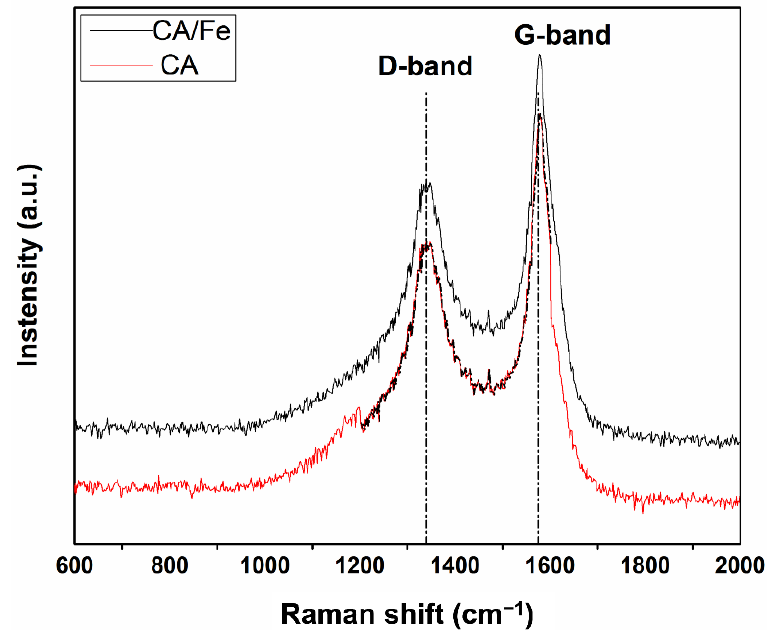
Figure 6. Raman spectra of Fe/CA and CA.